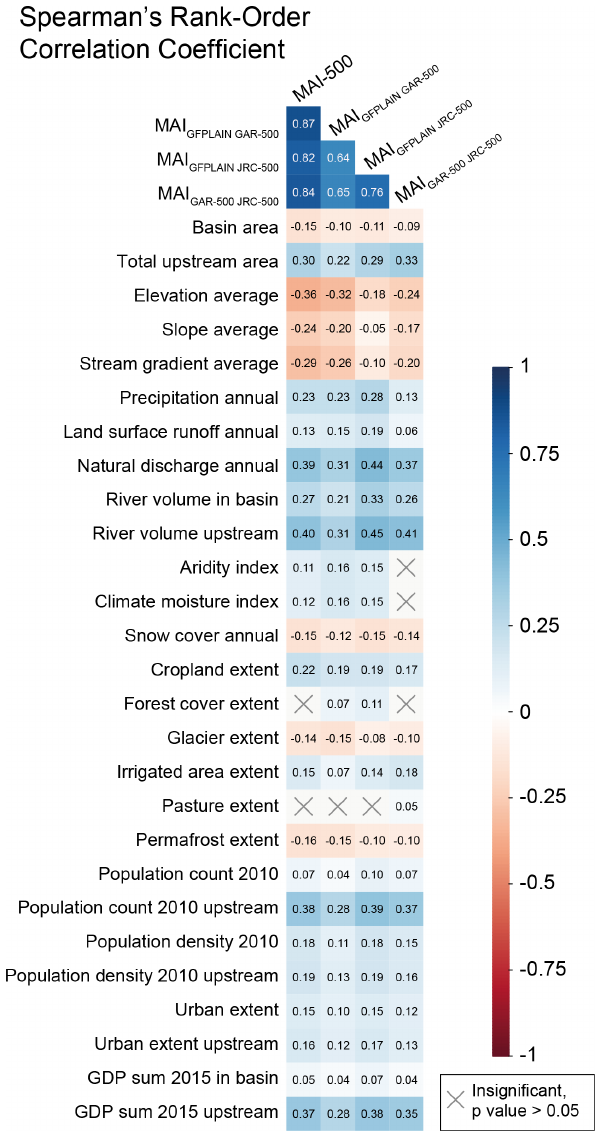
Figure 5. Spearman’s rank-order correlation coefficients between the flood model agreement scores and 27 hydro-environmental at- tributes. Wetter conditions due to climate (precipitation, land sur- face run-off) and river size (e.g. river volume, natural discharge) are positively associated with the model agreement between the flood maps. Topographic variables like high altitude (elevation) and steep slope (e.g. slope and stream gradient) are negatively associated with the model agreement, especially between GFPLAIN and GAR-500. Please note that the aridity index increases with humidity.